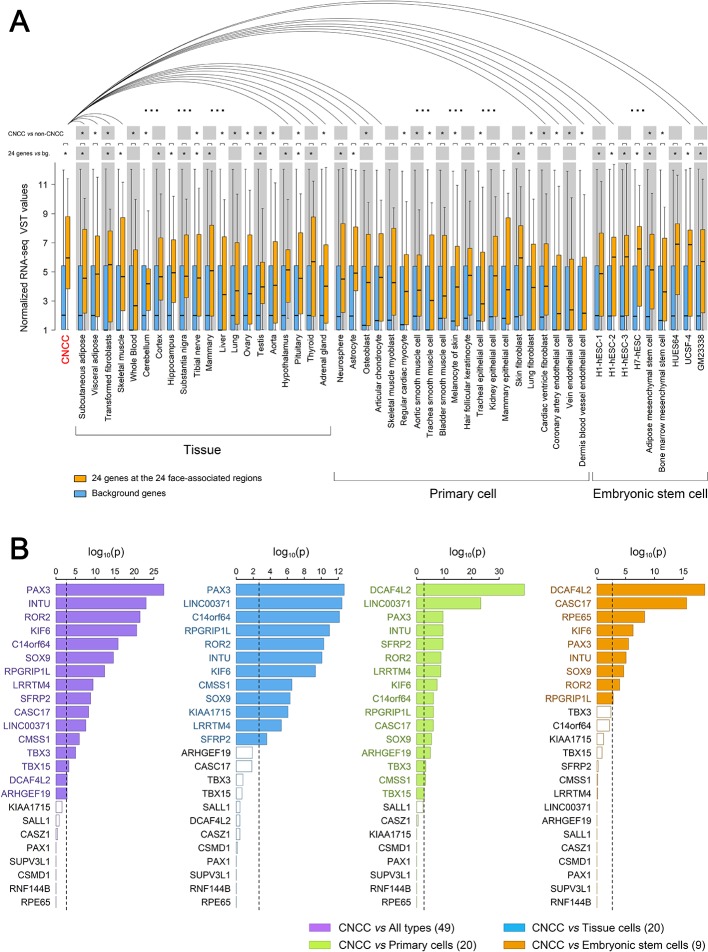
Expression of 24 genes located at the identified 24 face-associated genetic loci in 50 cell types.Expression levels of the genes nearest to the 24 top-associated SNPs (see Table 1) in 50 cell types were displayed in boxplots based on published data from the study of Prescott et al. (2015), the GTEx database (Lonsdale et al., 2013) and the ENCODE database (ENCODE Project Consortium, 2012). The cell types included CNCC, 20 other tissue cells, 20 primary cells and nine embryonic stem cells. (A) Boxplots of normalized RNA-seq VST values for the 24 genes (in orange) and all genome background genes (~50,000 genes, in blue). Expression difference between the genome background genes and the 24 genes was tested in each cell type using the unpaired Wilcoxon rank-sum test. Distribution of the expression levels in CNCC showed smaller variation than those of several embryonic stem cells which showed higher median. The expression of the 24 genes in CNCCs was also iteratively compared with that in other cell types using paired Wilcoxon rank-sum test. Statistical significance was indicated: *p<0.05 after multiple correcting test of cell lines amount. (B) Difference significance of normalized RNA-seq VST values in each of 24 genes were displayed using barplots between CNCCs and all 49 types of cells (purple), CNCCs and 20 tissue cells (blue), CNCCs and 20 primary cells (green), CNCCs and nine embryonic stem cells (orange). The difference between the value of CNCCs and other cell type groups was tested using the one-sample Student’s t test. Dotted line represents Bonferroni corrected significant threshold (p<0.0021). Significant gene labels were in color compared to non-significant gene labels in black.